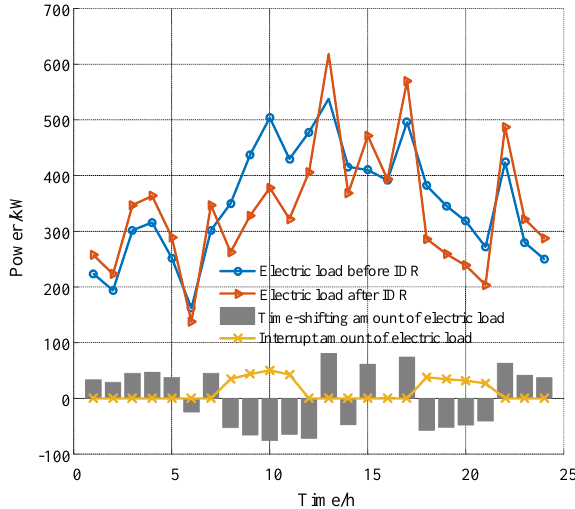
Figure 7. Comparison of the PIES electric load operation plans before and after IDR.